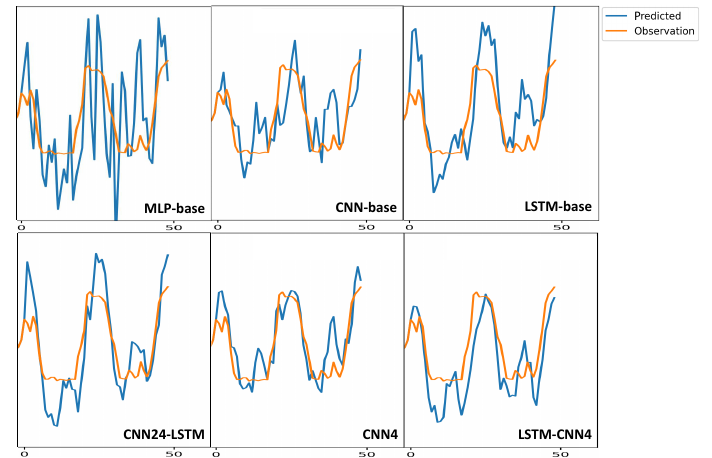
Figure 10. A 48 h ozone forecasting by the proposed and baseline models for Esenyurt station (predicted period: 16 April 2019 8:00 a.m.–18 April 2019 8:00 a.m.).